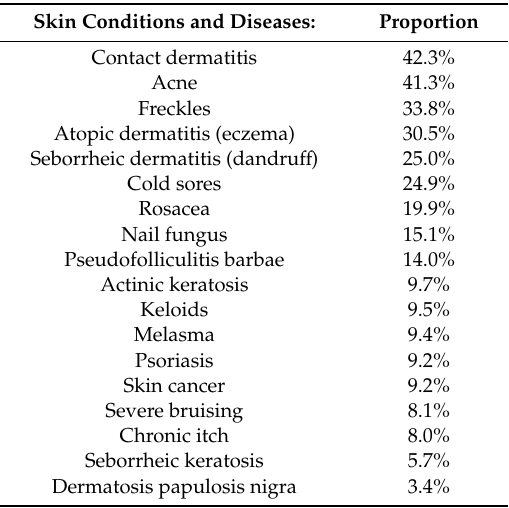
Table 1. Skin conditions and diseases reported by participants with sensitive skin. Skin Conditions and Diseases: